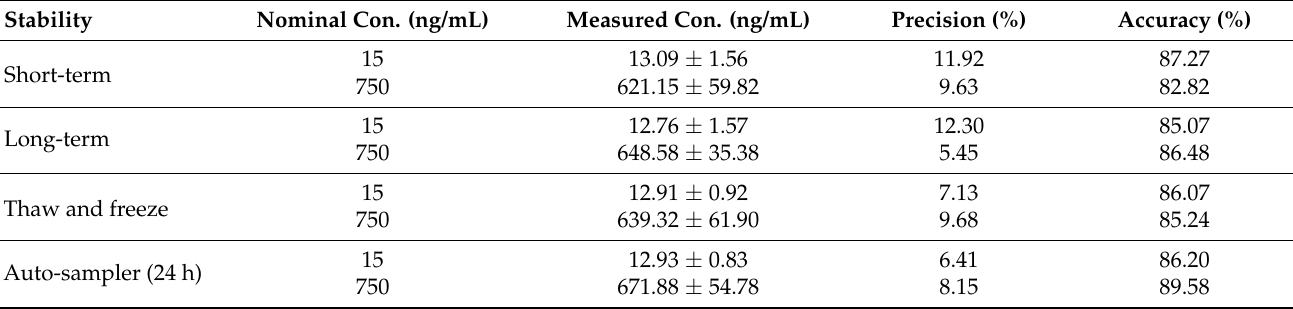
Table 4. Stability of ERDA in plasma under different processing and storage conditions.